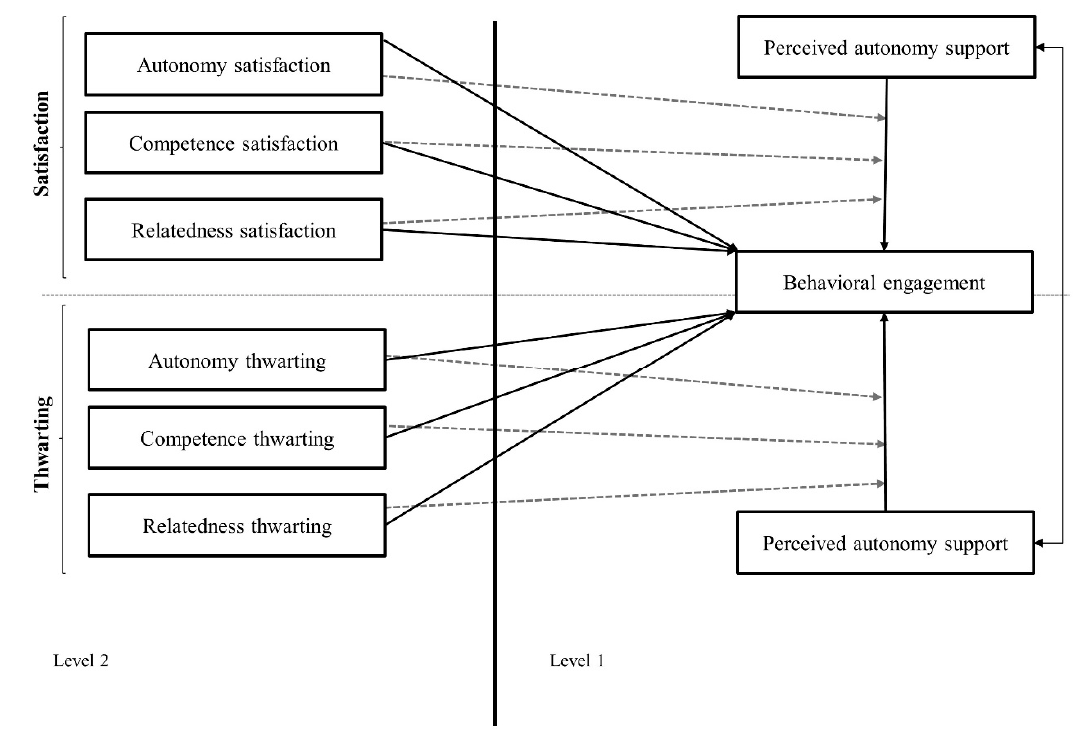
Figure 1. Multilevel models tested.